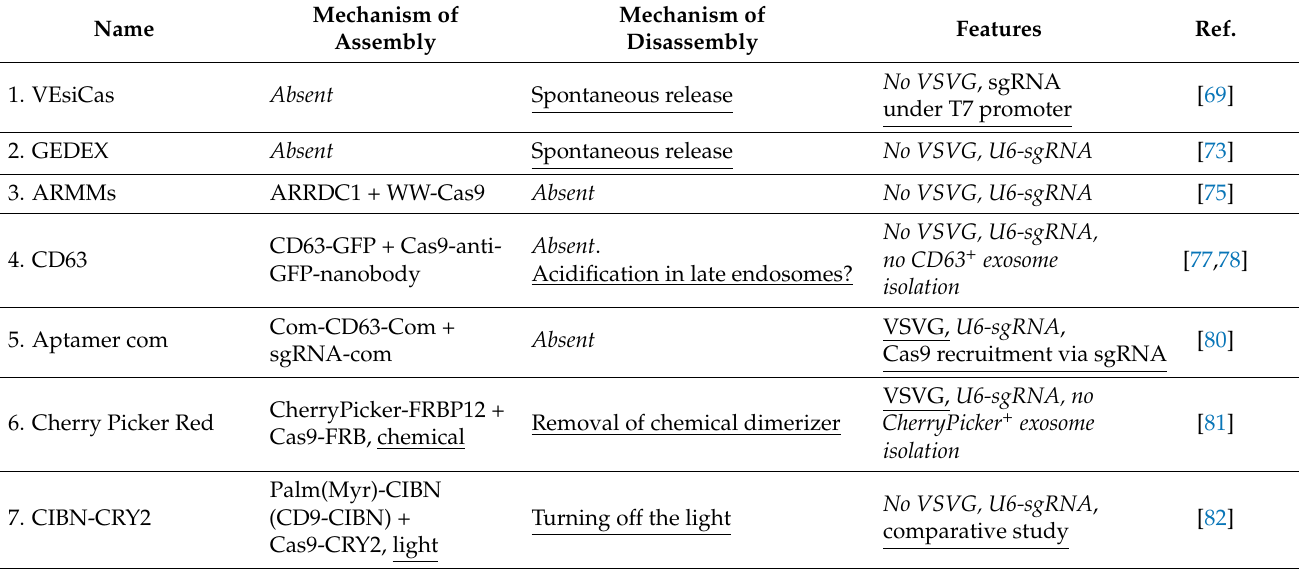
Table 1. Current systems for delivery of Cas9 RNP using EVs. The pros and cons of each system are indicated by underlining or italicizing,